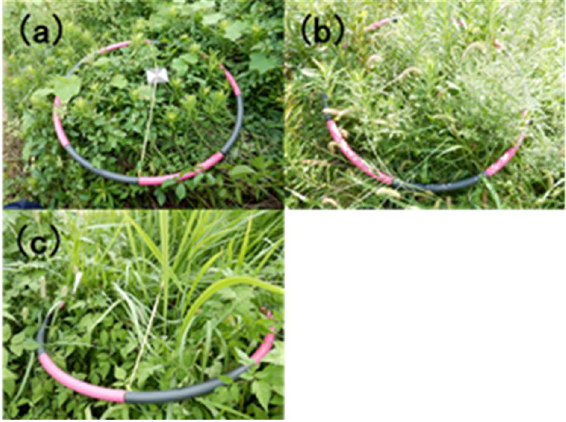
Figure 8. Forb species which prevent UAV LiDAR penetration into bottom vegetation layer (0-50 cm) when they are present in middle vegetation layer (50-100